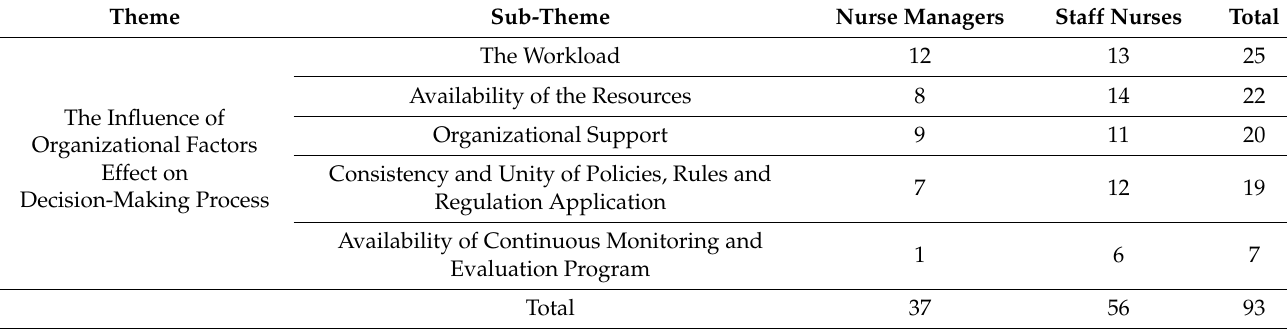
Table 2. Comparison of organizational factors’ effect on decision-making process between nurse managers and staff nurses.